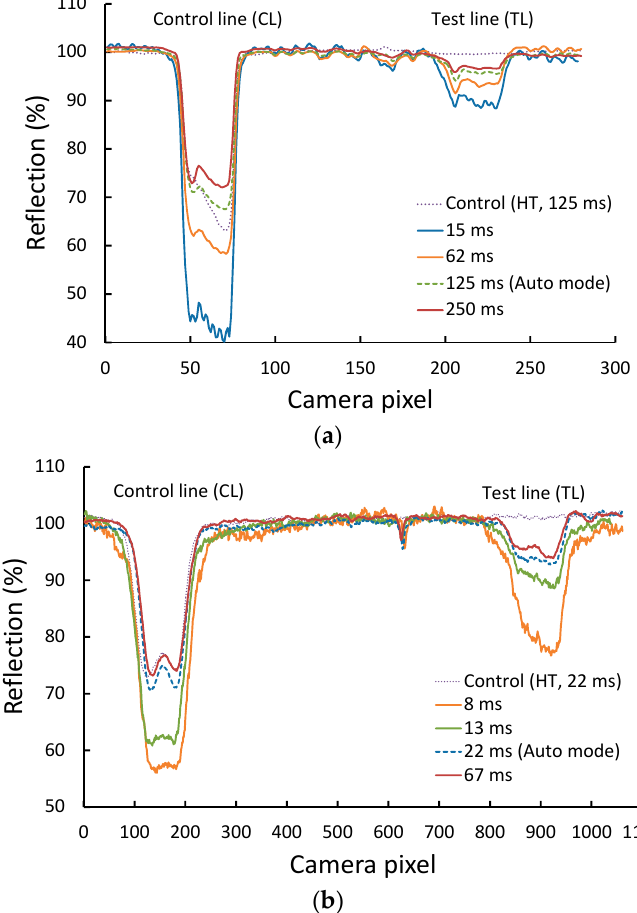
Figure 2. Reflected light profiles from the test area of the test strip at a bacteria concentration of 1 × 10 6 CFU/mL. The image of the LFA strip was captured with different camera exposure times when using ( a ) a web cam reader and ( b ) an iPhone reader.